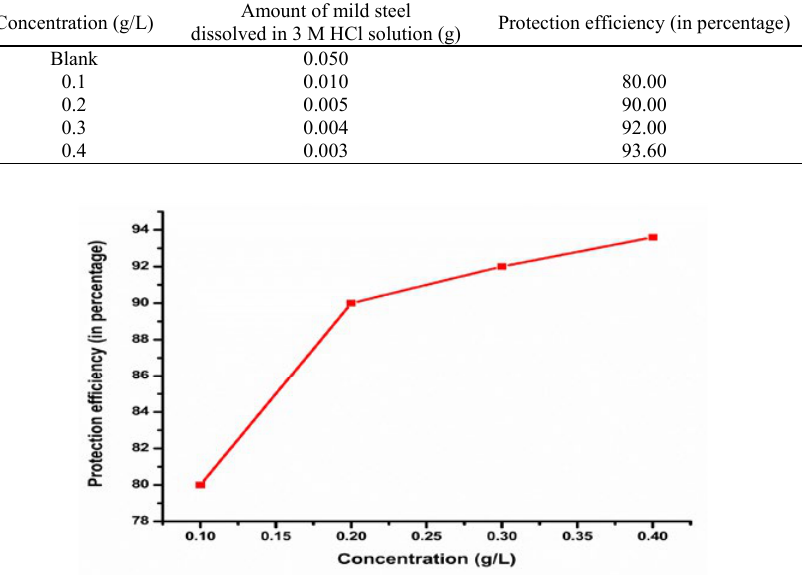
Fig. 4. Variations of protection efficiency at different amounts of plant extract